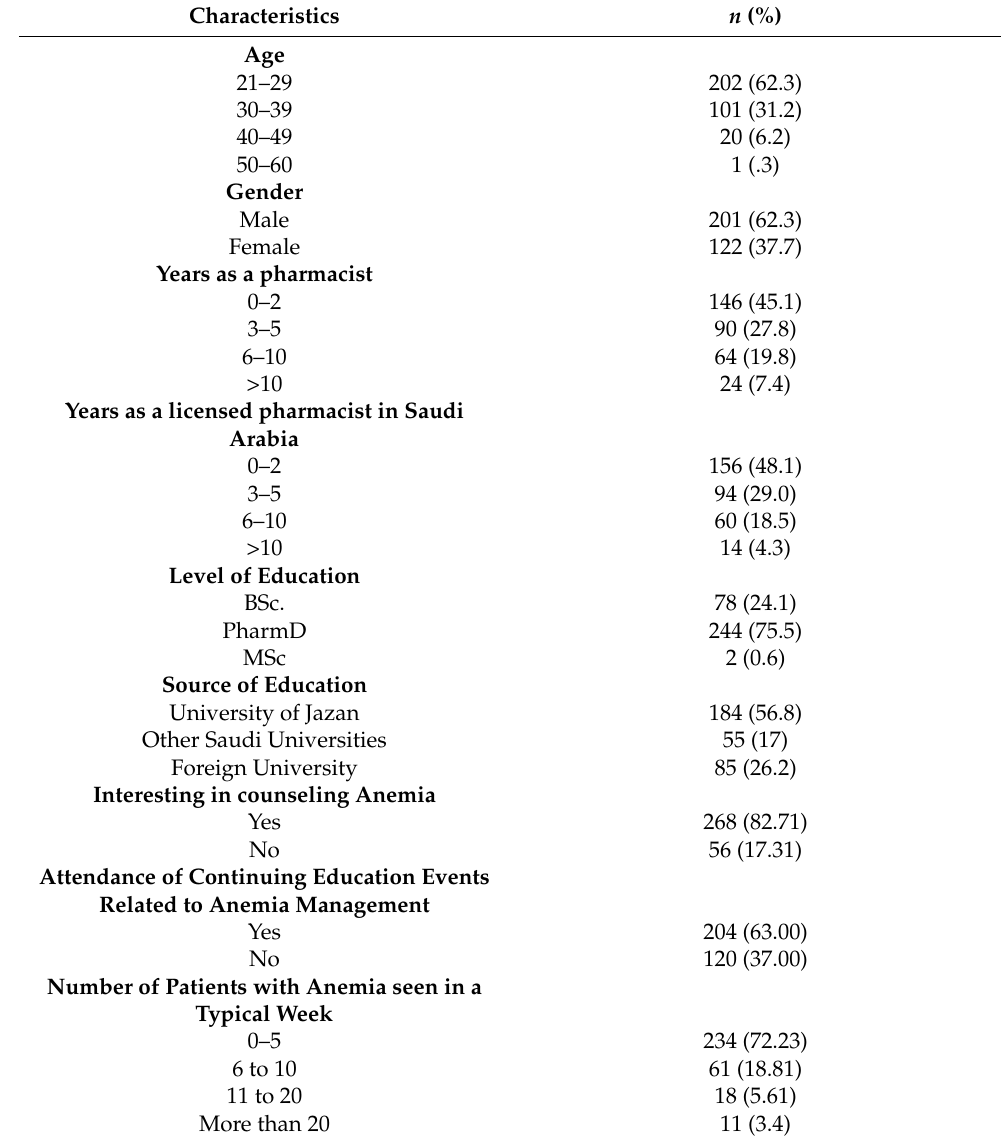
Table 2. Demographic and practice